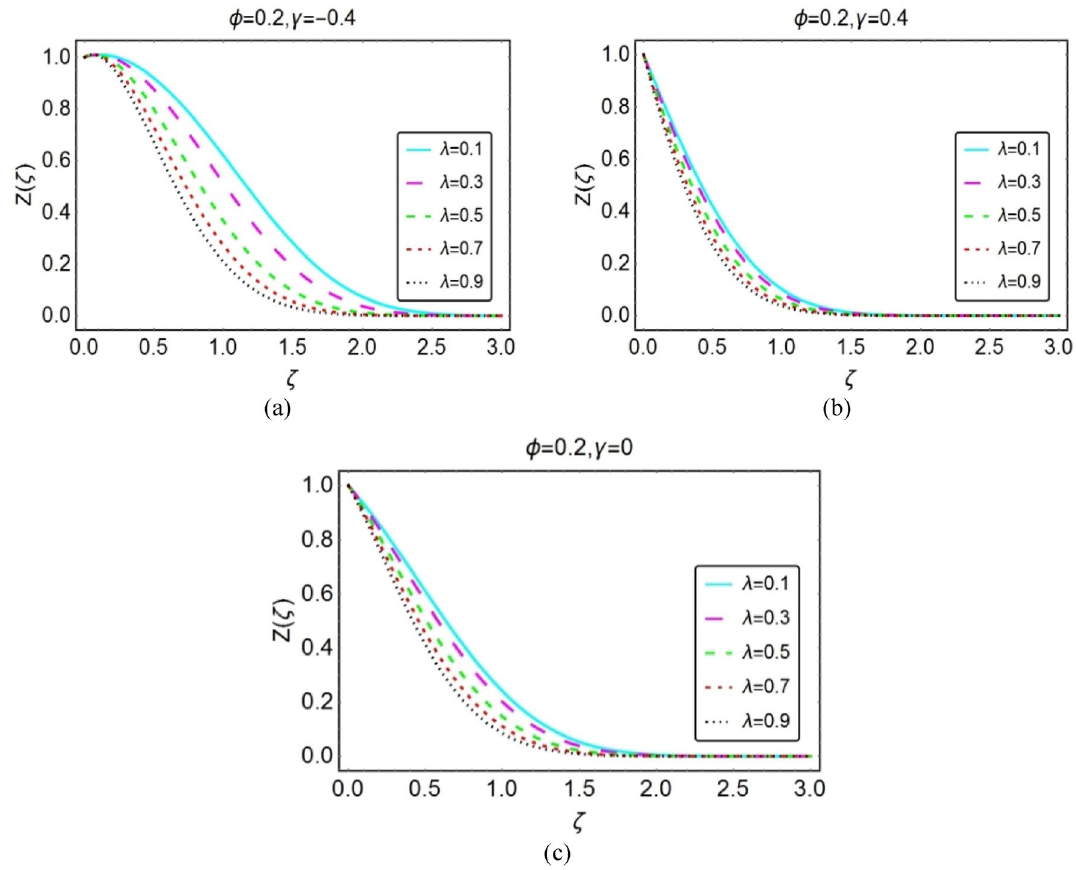
Figure 5. Impacts of (cid:31) on Z (ζ) for ( a ) opposing ( b ) assisting and ( c ) static